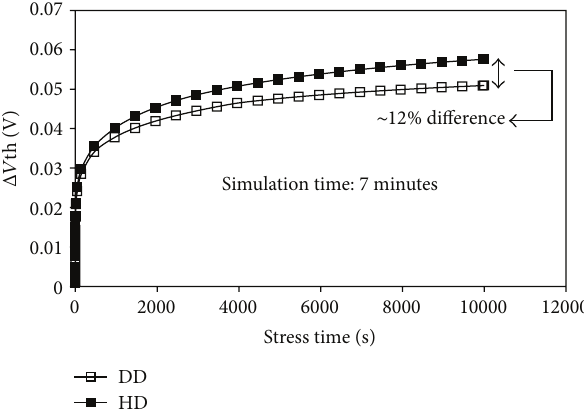
Figure 4: Comparison of NBTI-induced threshold voltage shift computed by hydrodynamic (HD) transport model and drift diffu- sion (DD) model. The DD model underestimates the degradation particularly at extended stress